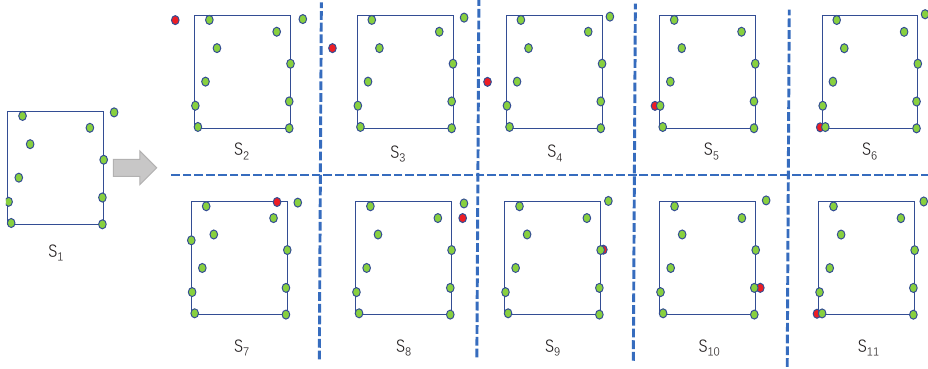
Figure 5. Overview of the transformation state generation process from s 1 to s 2 ,... s 11